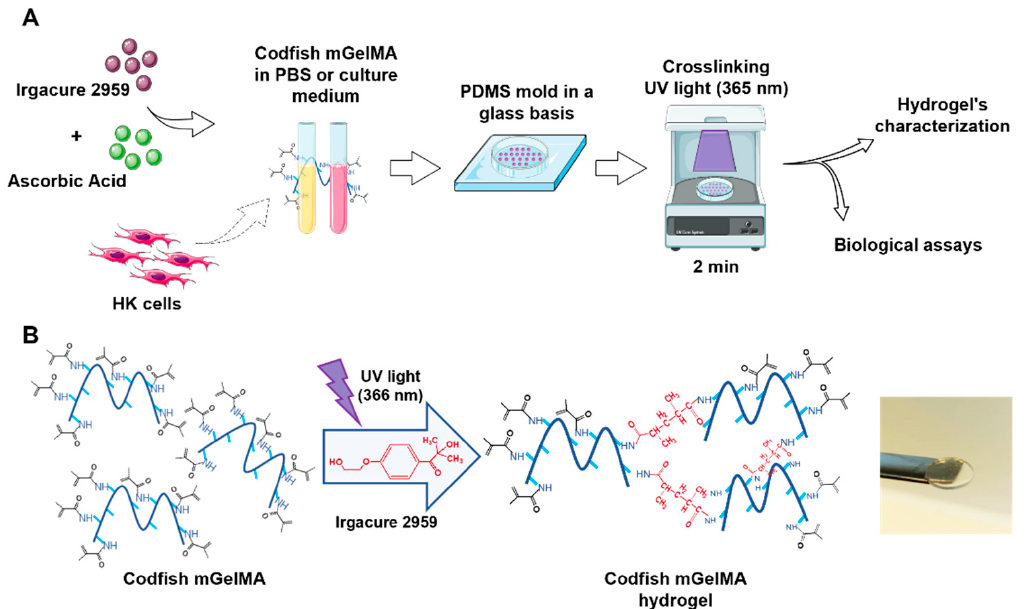
Figure 3. Summary of codfish mGelMA hydrogel assembly. ( A ) Schematic representation of hydrogel production with or without HK cells. ( B ) Representative scheme of the reaction between codfish mGelMA polymer and the photoinitiator to obtain crosslinked hydrogels.